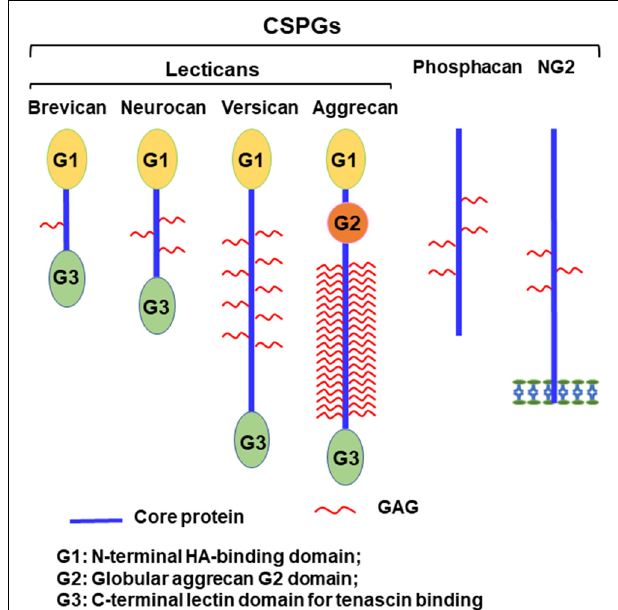
FIGURE 1 | Schematic of chondroitin sulfate proteoglycans (CSPG) molecules expressed in the CNS. Lecticans include a core protein with globular G1 (N-terminal) and G3 (C-terminal) domains linked by a central domain to the chondroitin sulfate glycosaminoglycan (CS-GAG) chains. Unlike other lecticans, aggrecan also has a G2 domain linked to G1 by an interglobular domain. The G1 domain binds to hyaluronan and to link proteins, while the G3 domain interacts with tenascins and glycolipids through a lectin-like region. Phosphacan is a secreted splice variant of transmembrane receptor-type protein tyrosine phosphatase β (PTP β ). NG2 is a transmembrane proteoglycan and exists in a soluble form after its proteolytic